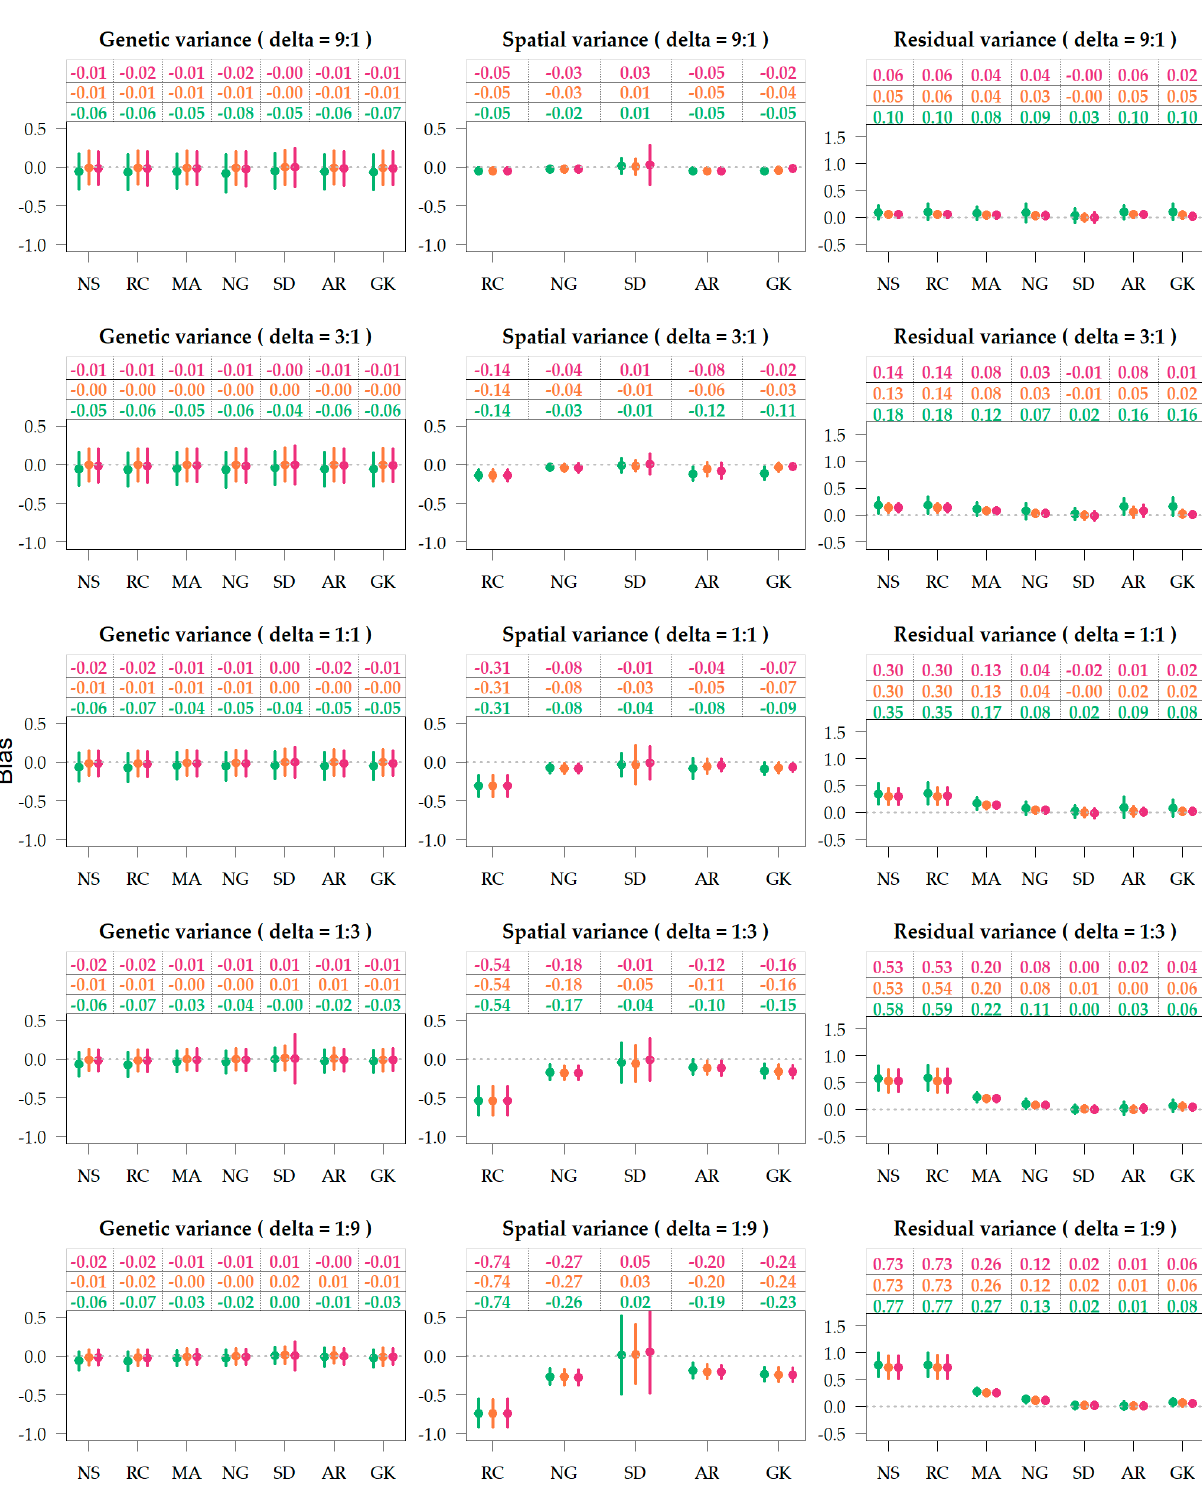
Figure 4. Variance bias of genetic, spatial and residual terms, under varying residual-to-spatial variance ratios ( δ = σ 2 e : σ 2 s ). Colors correspond to the genetic relationship: Identity (green), pedigree (orange), genomics (red). Spatial adjustment methods on x -axis: no spatial adjustment (NS), row-column (RC), moving average covariate (MA), autoregressive AR1 × AR1 (AR), SPDE (SD), nearest neighbor graph (NG), and Gaussian kernel (GK). Across the various scenarios, the accuracy of genetic effects varied from 0.569 to 0.782. Based on the marginal averages (Table 1), the genetic accuracy increased from no